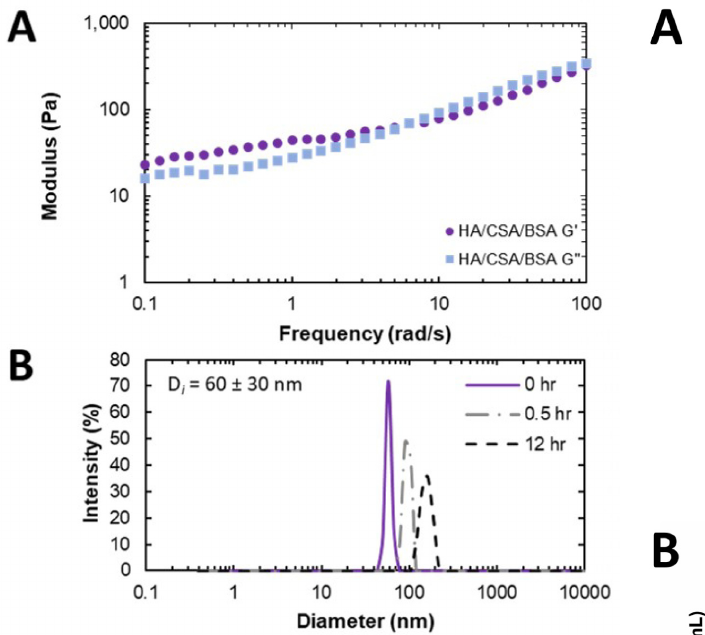
Figure 5. Blend characterization. ( A ) Oscillatory frequency sweeps of protein-polysaccharide blend. ( B ) Qualitative time-resolved dynamic light scattering experiment of the sheared blend. Dataset 1: Rheology and dynamic light scattering